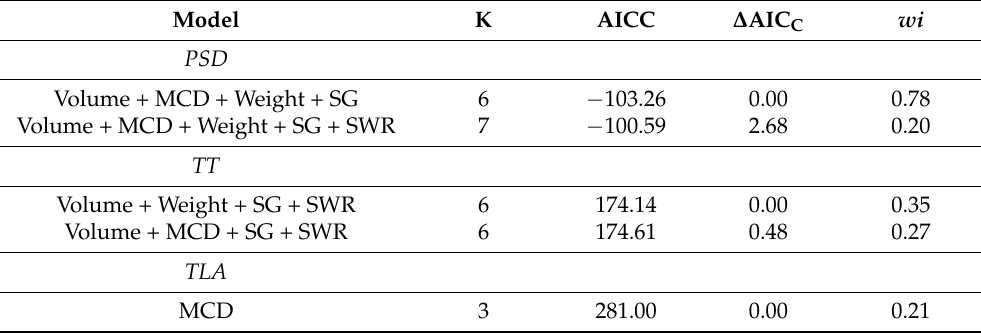
Table 1. Model selection and performance measures for models used to explain the effect of different physical characteristics of seeds ingested by Tibetan macaques on PSD and passage time. Model K AICC ∆ AIC C wi PSD Volume + MCD + Weight + SG 6 − 103.26 0.00 0.78 Volume + MCD + Weight + SG + SWR 7 − 100.59 2.68 0.20 TT Volume + Weight + SG + SWR